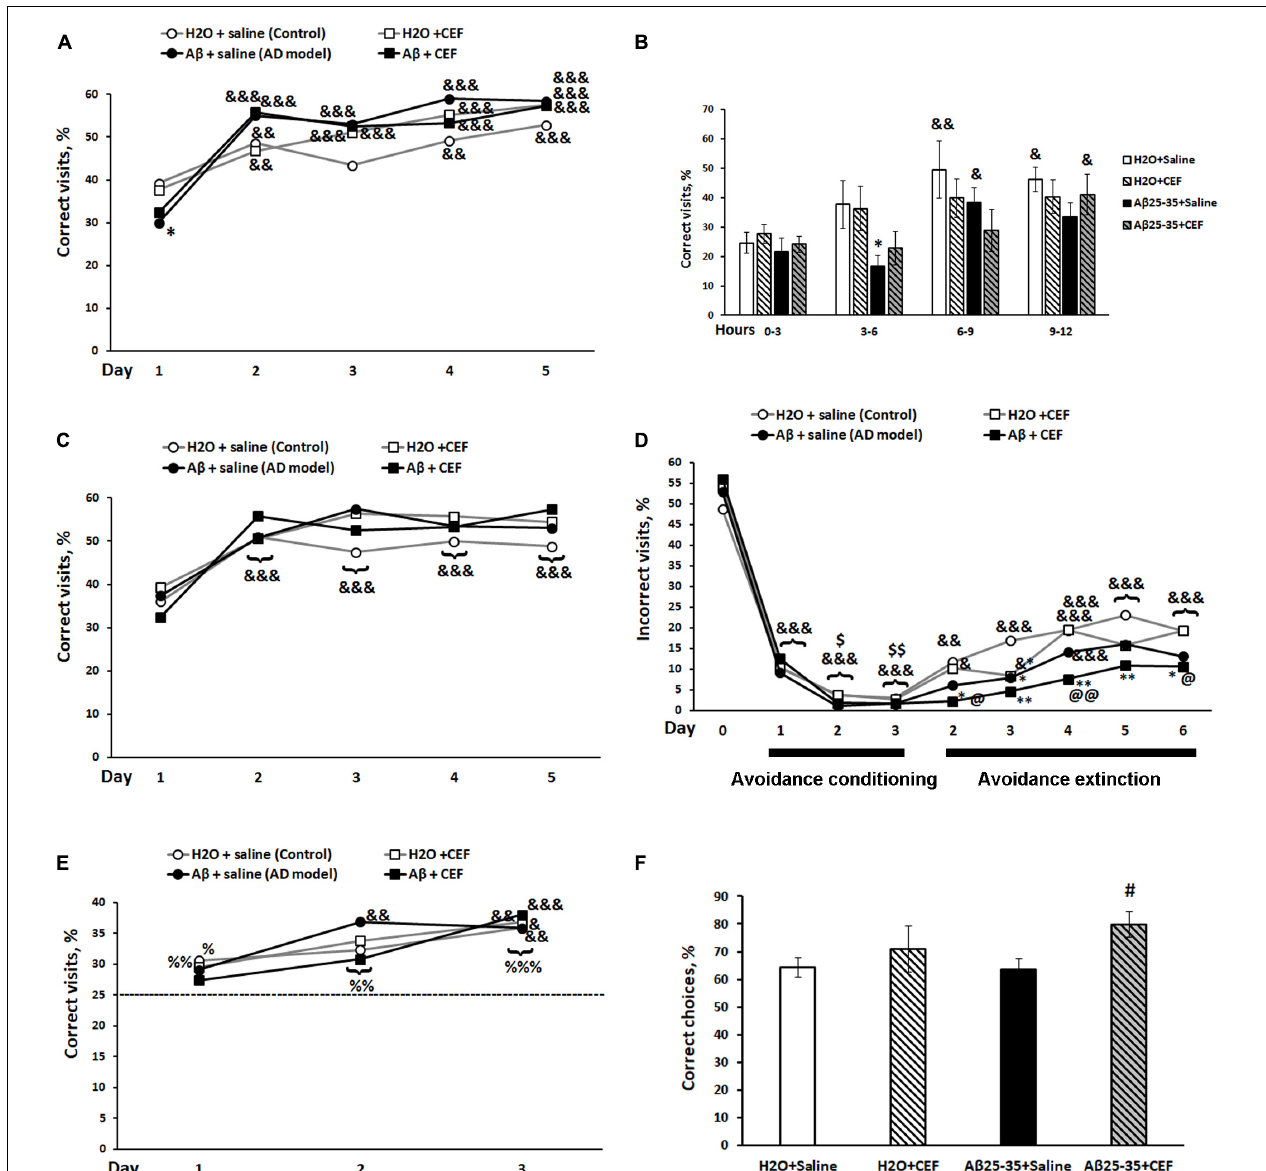
FIGURE 3 | Effects of the CEF and A β 25–35 administration (AD model) on the place learning (A,B) , place learning reversal (C) , avoidance conditioning and extinction (D) , patrolling behavior (E) in the IntelliCage, or on the working spatial memory in the T -maze test (F) in mice. The dynamics of place learning in the IntelliCage was evaluated during the whole period of the test with the values pooled daily (A) or during the first day of this phase of the test with the values pooled for 3 h (B) . The data are expressed as means (A,C–E) or mean ± SEM (B,F) of the values obtained in an independent group of animals ( n = 7–8 per group). Statistically significant differences: & p < 0.05, && p < 0.01, &&& p < 0.001 compared with values of the same group at the first timepoint of the phase, for avoidance conditioning—compared with values of the same group on the last day of the previous phase (day 0 in the figure), for avoidance extinction—compared with values of the same group on the last day of the previous phase (day 3 of the avoidance conditioning test); $ p < 0.05, $$ p < 0.01 compared with values of the same group on the first day of the avoidance conditioning test; % p < 0.05, %% p < 0.01, %%% p < 0.001 compared with the chance level (25%); ∗ p < 0.05, ∗∗ p < 0.01 compared with respective values of the “H 2 O + saline” group; # p < 0.05 compared with respective values of the “A β + saline” group; @ p < 0.05, @@ p < 0.01 compared with respective values of the “H 2 O + CEF”